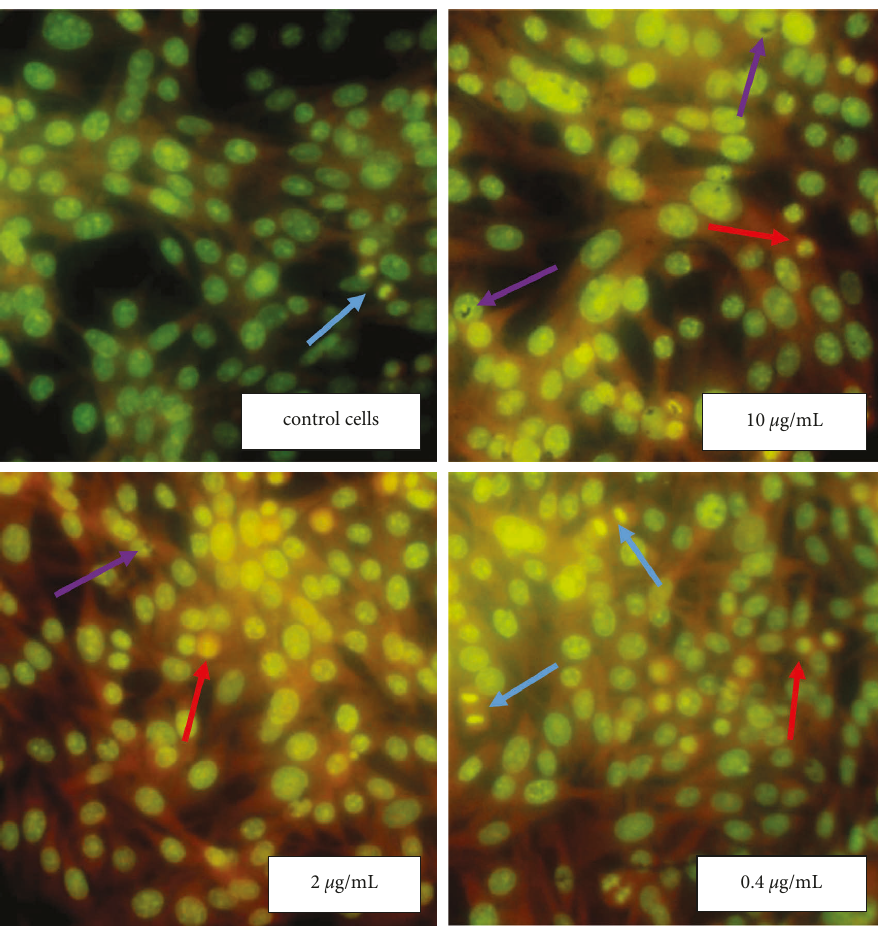
Figure 5: Morphological changes of BHK-21 cells exposure Ag NPs. The cells morphology after Ag NPs treatment were analyzed by fluorescent microscopy after staining with acridine orange. In noncancerous cell BHK-21, regardless of nanoparticles concentrations the cellular parameters were similar to the untreated control cells. Red arrows show necrotic cells, and blue arrows − mitotic cells, while purple arrows show conglomerates of NPs (280 × Table 1: Cytomorphological study of Ofr -2 and COL -21 cells treated with silver NPs. Ofr -2